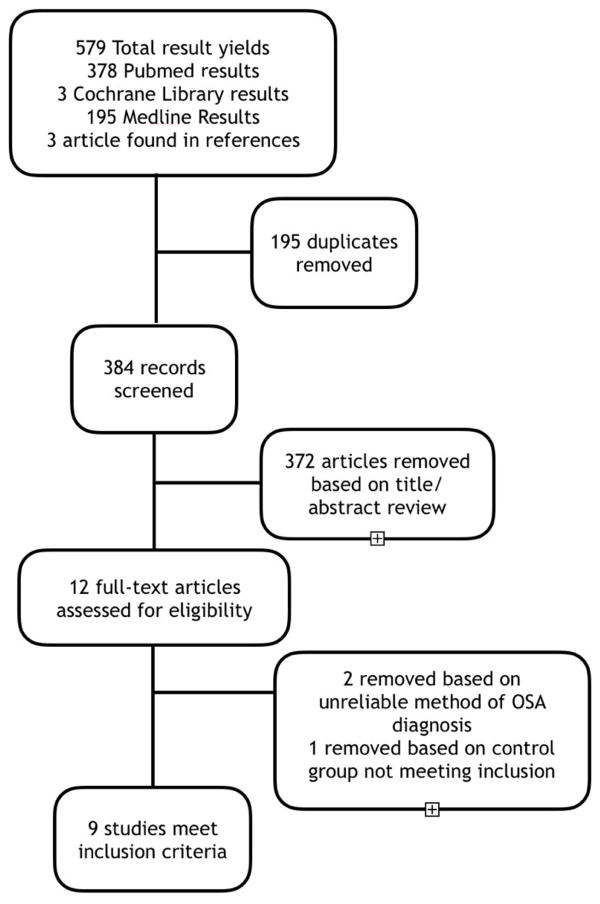
Flow diagram explaining the process of selections of the studies included in our meta-analysis.